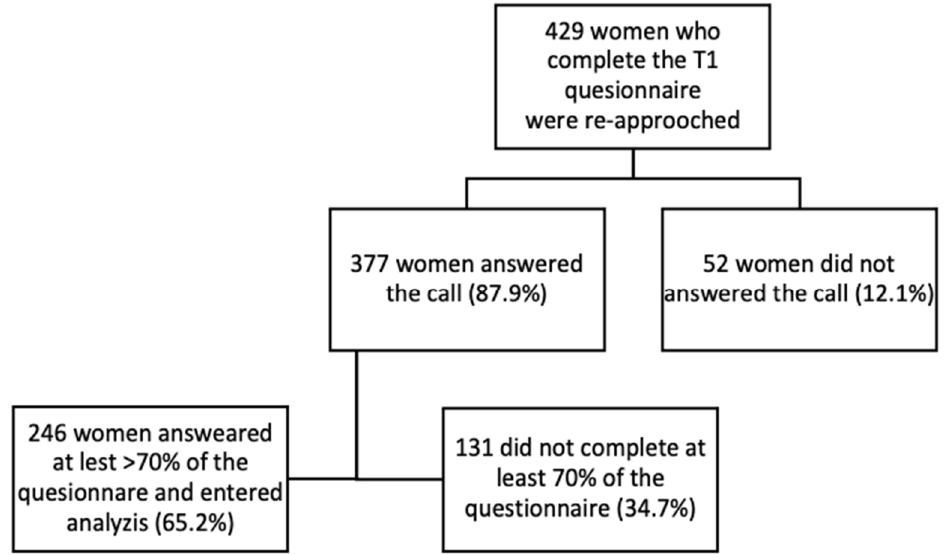
Figure 1. Study cohort.